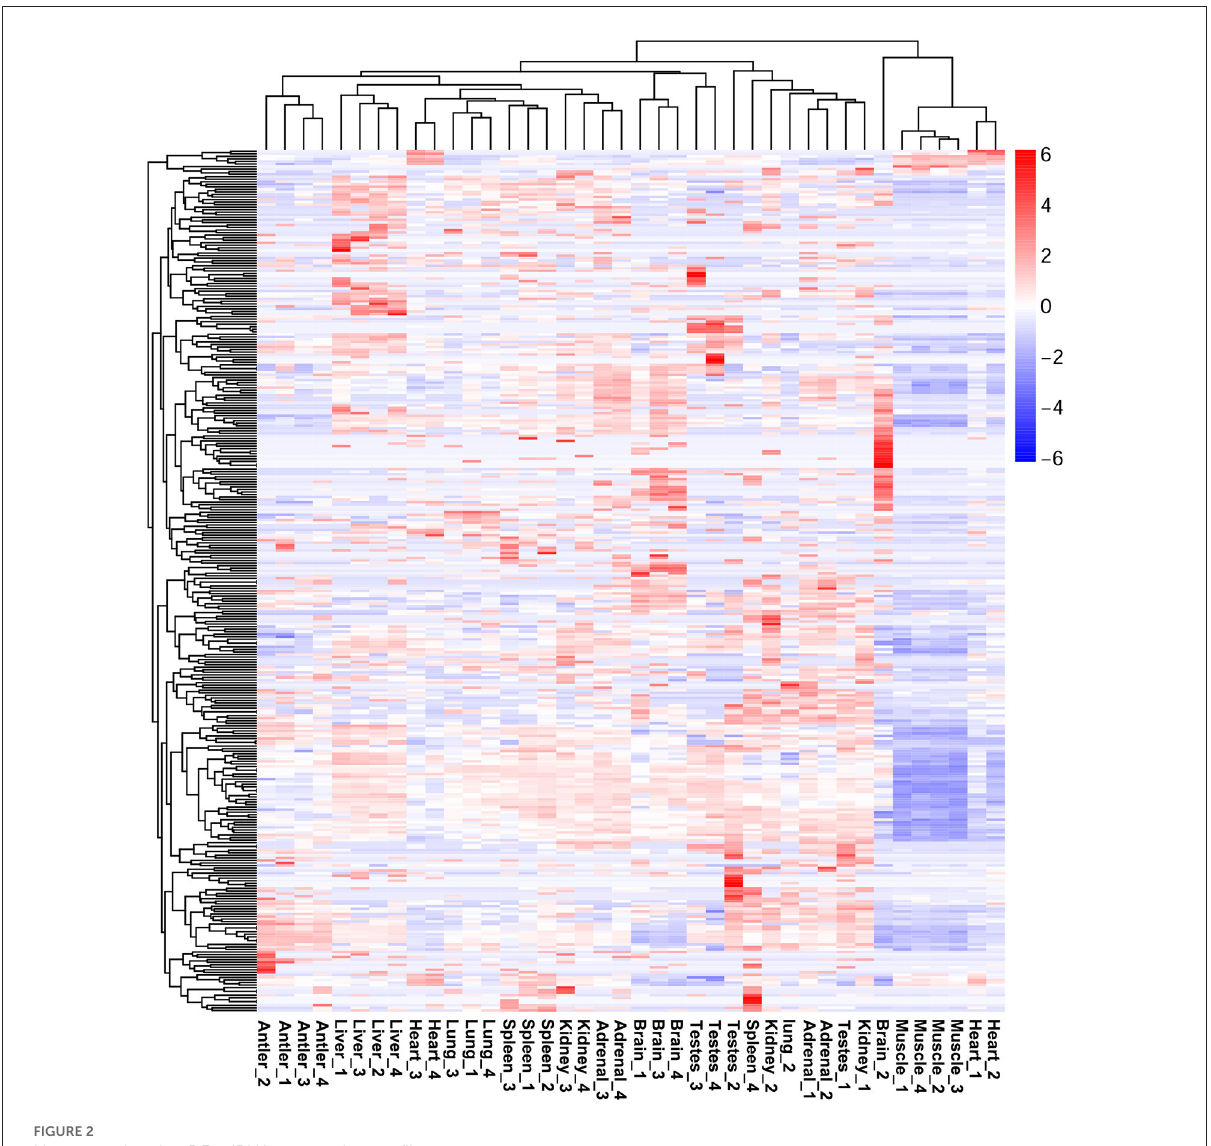
FIGURE2 Heat map showing DE miRNAs expression